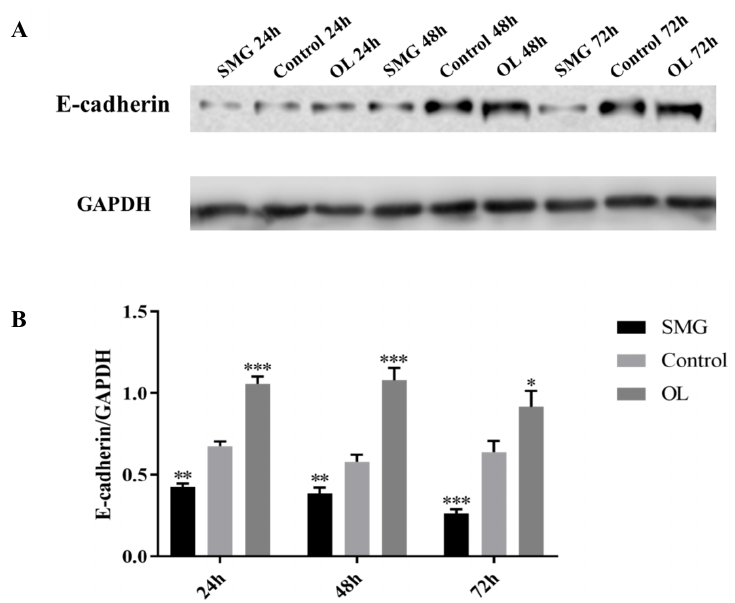
Figure 12. Western blot analysis of E-cadherin in MCF-7 cells after mechanical changes. ( A ) Results for Western blots. ( B ) Reflective densitometry of Western blots. * p < 0.05, Significant di ff erence; ** p < 0.01 and *** p < 0.001extremely significant.